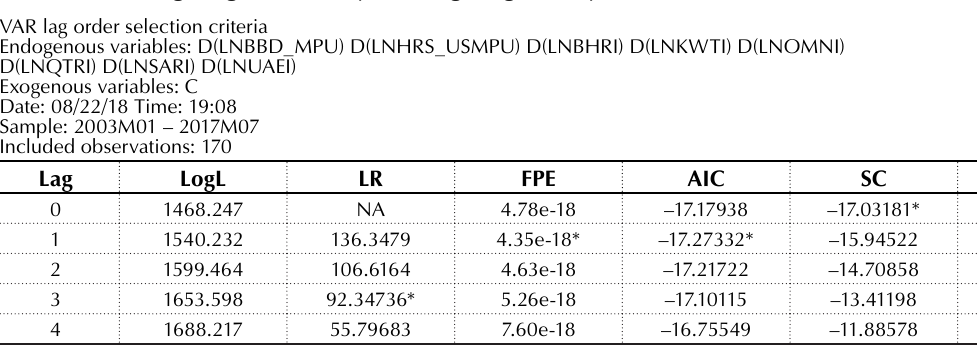
Table A2. The lag length criteria (initial lag length of 4)